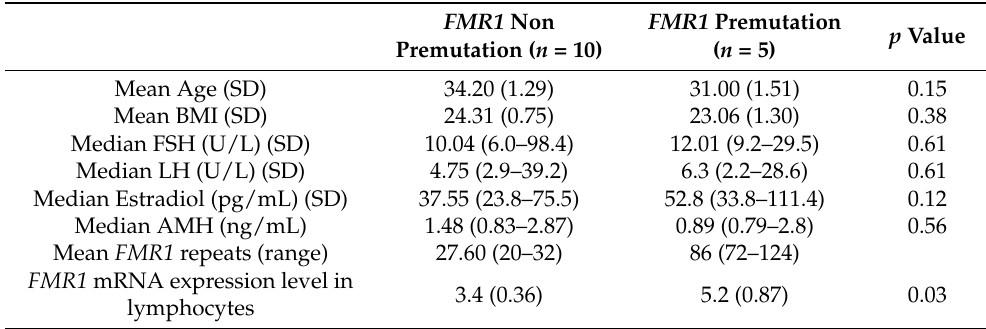
Table 1. Clinical and laboratory characteristics of study participants: fragile X mental retardation 1 (FMR1) premutation (PM) and non (PM) groups. FMR1